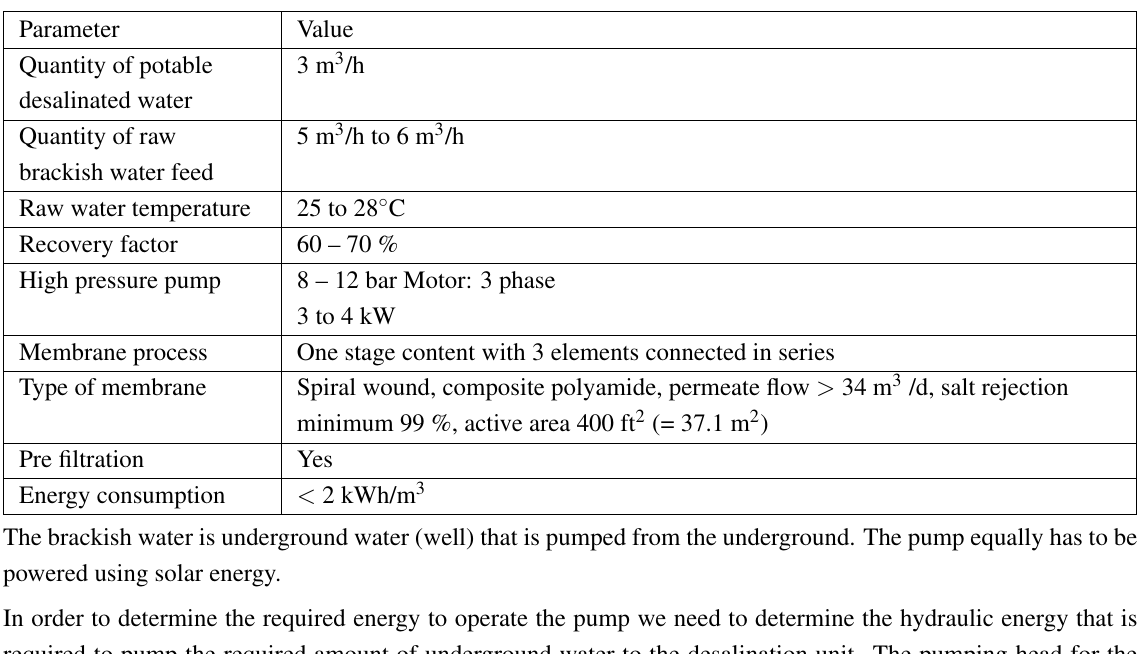
Table 2. Parameters of the desalination